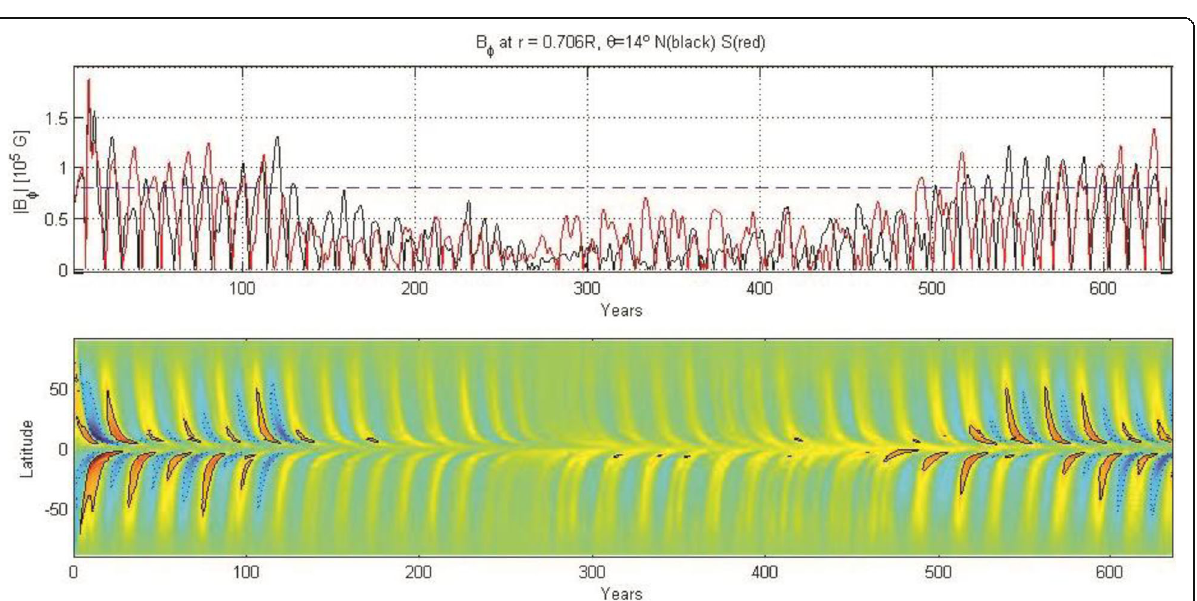
Fig. 8 A kinematic solar dynamo simulation with stochastically fluctuating mean-field α -effect and Babcock-Leighton sources for the poloidal field shows long-term modulation in activity (Passos et al. 2014). The top panel depicts simulated sunspot time series in the northern (black) and southern (red) hemispheres and the bottom panel depicts the simulated solar butterfly diagram for the toroidal field at the base of the convection zone. The dynamo simulation is characterized by hemispheric asymmetry in activity, parity shifts, and occasional sunspot eruptions during the grand minimum phase observed in the simulated timeframe